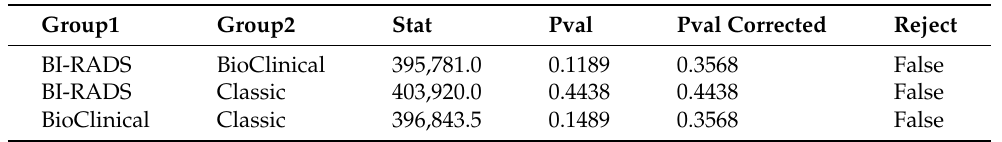
Table A7. Bonferonni-corrected Mann–Whitney U test results for section segmentation with auxil- iary data.